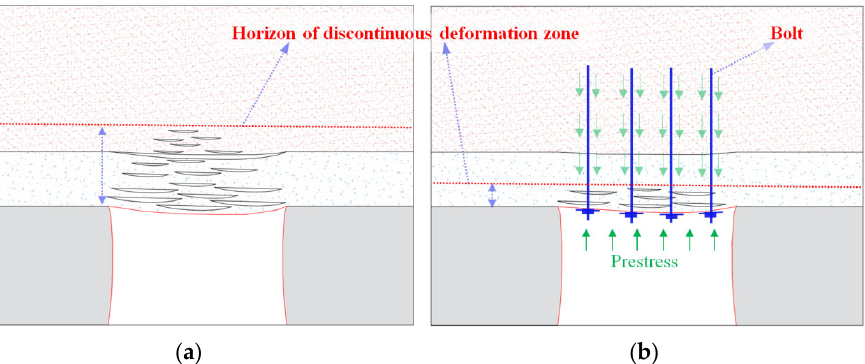
Figure 11. Cross ‐ boundary linkage control technology of the thick anchorage layer of the roof: ( a ) roadway roof not supported at the buried depth of 600 m; ( b ) thick anchorage layer of the roadway roof supported at the buried depth of 600 m.